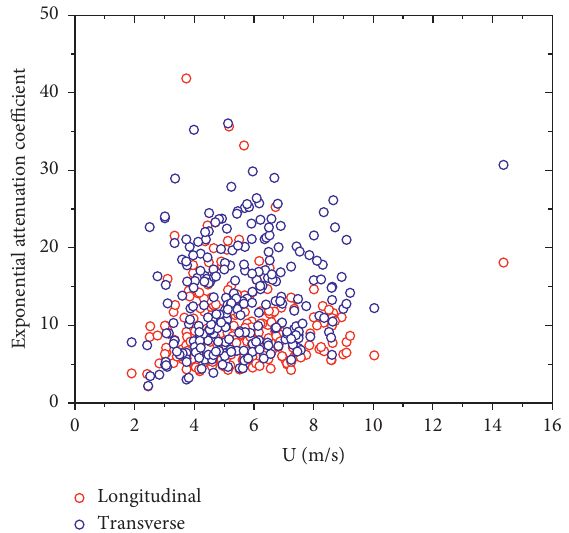
Figure 8: Exponential attenuation coefficient varying with the mean wind speed.